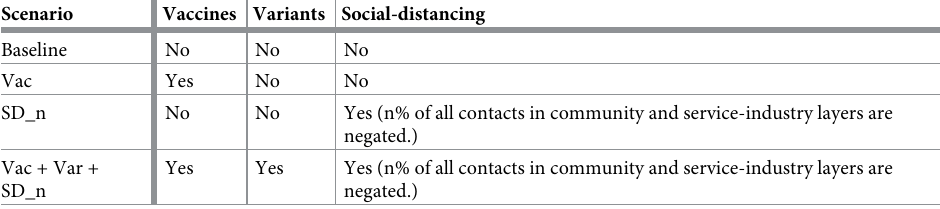
Table 6. Scenarios to compare the difference between the two responses. Scenario Vaccines Variants Social-distancing Baseline No No No Vac Yes No No SD_n No No Yes (n% of all contacts in community and service-industry layers are negated.) Vac + Var + Yes Yes Yes (n% of all contacts in community and service-industry layers are SD_n